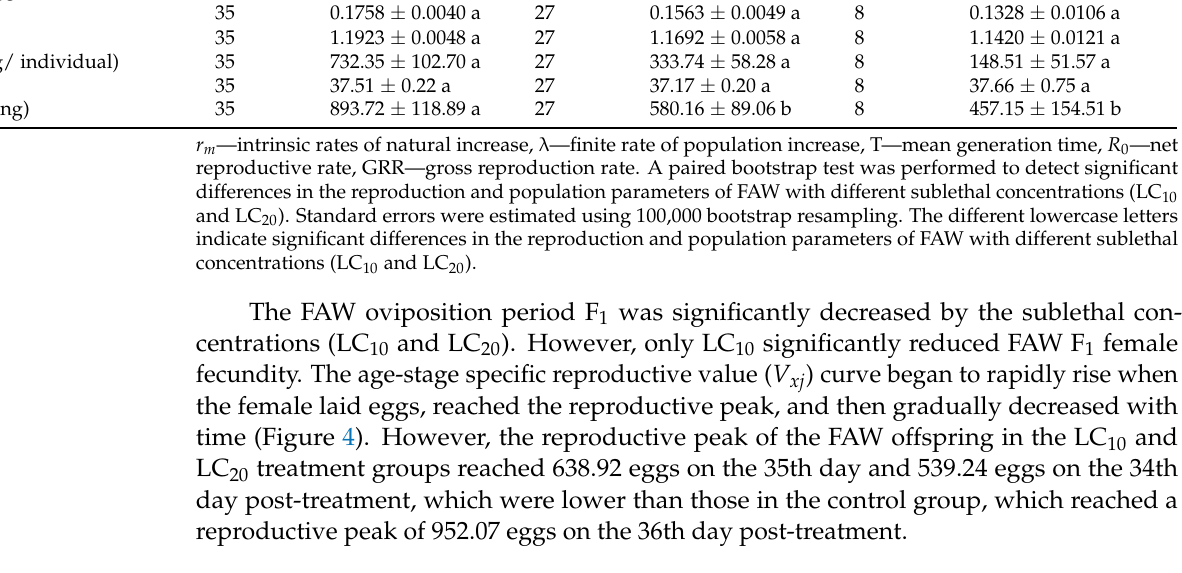
Figure 2. Age-specific survival rate ( l x ), age-specific fecundity ( m x ), and age-specific maternity ( l x m x ) curves of the FAW offspring generation from the FAW parental generation exposed to sublethal concentrations (LC 10 and LC 20 ).